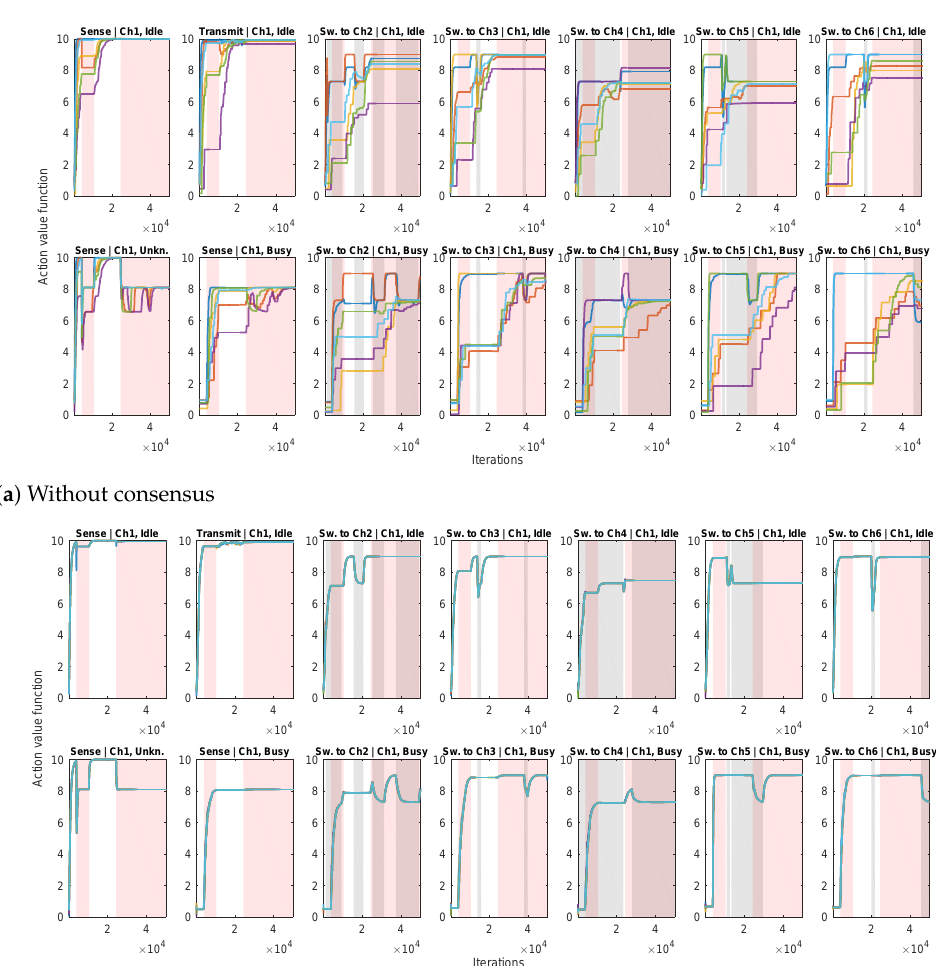
Figure 5. Action-value function estimations for all the possible actions from three states correspond- ing to a single channel (different plots with corresponding Action | State pairs given in the titles) and all agents (differently colored lines). Intervals when the considered single channel is busy are shown in shades of red. Intervals when the channels corresponding to destinations of switching actions are busy are shown in shades of